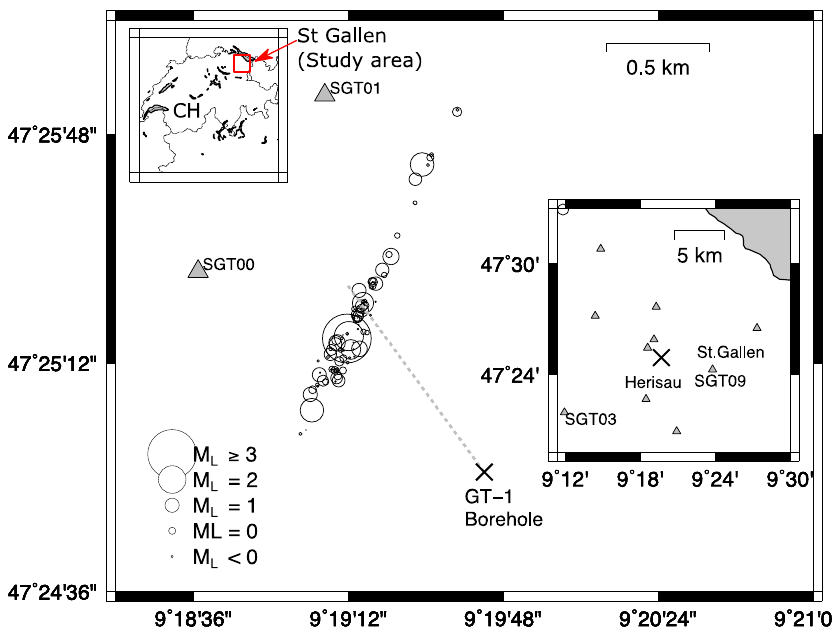
Figure 1. Plan view of the analyzed earthquakes. Circles representing earthquakes location are proportional to the magnitude of the event. Seismic network layout is indicated in the right bottom frame where the location of the two nearest urban areas from the well and the two sites (SGT03 and SGT09) selected for site-specific seismic hazard analysis is also indicated. The grey dashed line indicates the GT-1 well trajectory. The upper left inset indicates the location of the St Gallen study area in Switzerland.